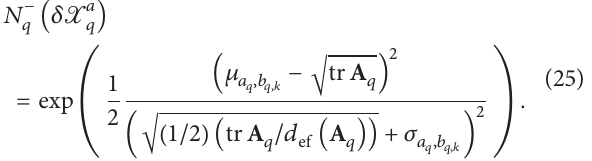
Figure 8: Histogram of distribution of | X 𝑎 𝑞,𝑘 − X 𝑎 𝑞 | deduced from the EnKF (and valid here for PF due to the equivalence in the Gaussian setting) (i.e., |𝜀 𝑎 𝑞,𝑘 | ) compared to the one of | X 𝑏 𝑞,𝑘 − X 𝑎 𝑞 | for an ensemble size of 𝑁 = 6400 samples. The maximum expected distance 𝑑 + 𝑎 | X 𝑎 − X 𝑎 | is the vertical segment in solid line. The minimum expected distance 𝑑 − 𝑞,𝑘 𝑞 The results are represented for the different length-scale values: (a) 𝐿 𝑝 = 10 km, (b) 𝐿 𝑝 = 100 km, (c) 𝐿 𝑝 = 500 km, and (d) 𝐿 𝑝 = 1000 km, for the dimension set to 𝑛 = 1000